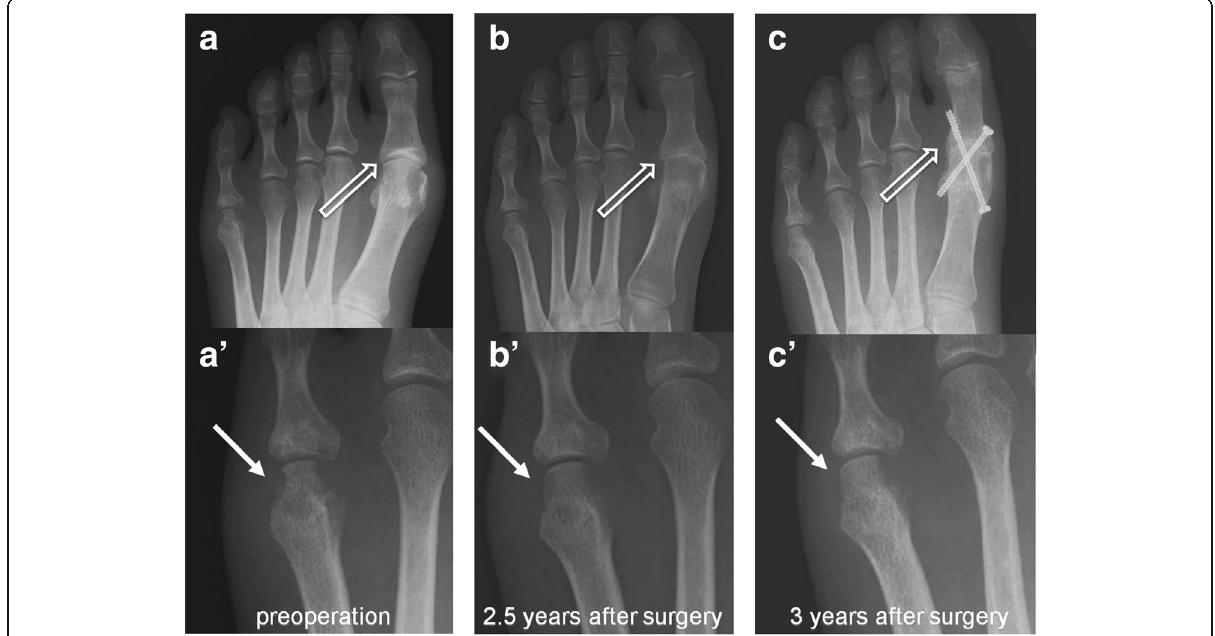
Fig. 6 a – c , a ′– c ′ Bone regeneration after synovectomy of the 5th metatarsophalangeal joint of the left foot. The left panel shows the preoperative radiograph of the left foot. Bone erosion was seen in the 5th metatarsal head. The middle panel shows the reappearance of the 5th metatarsal head 2.5 years after synovectomy of the joint. Joint space narrowing appeared at the 1st metatarsophalangeal joint. The right panel shows consolidation